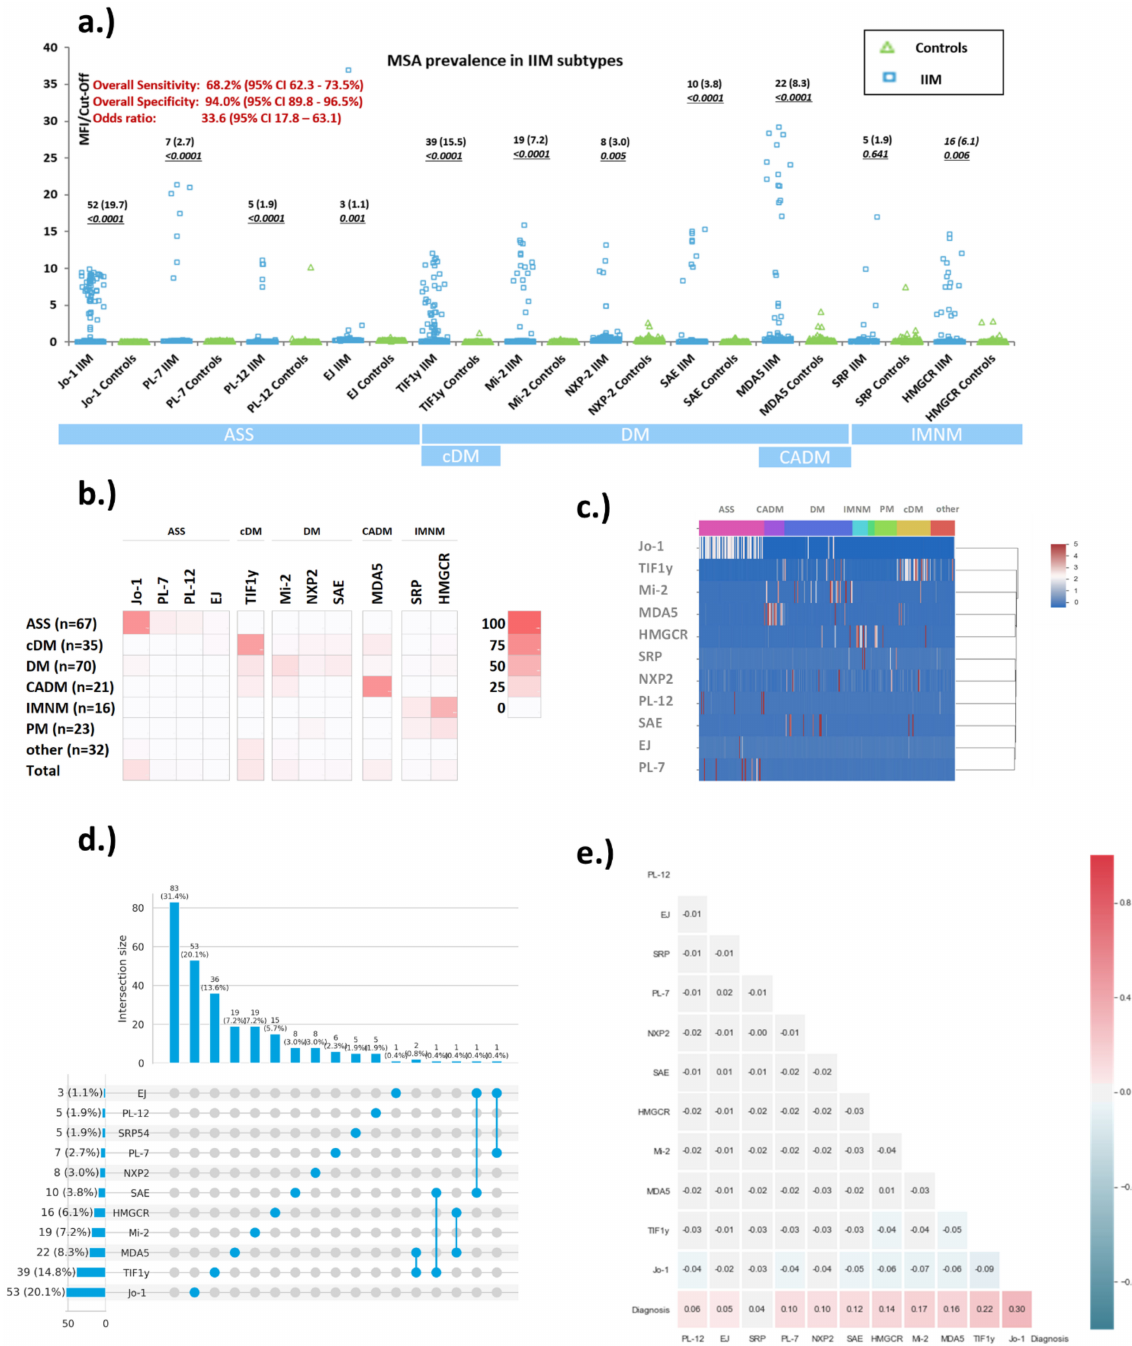
Figure 1. Reactivity of myositis specific antibodies in idiopathic inflammatory myopathy (IIM) patients and controls. ( a ) Scatter plot showing the levels of myositis specific antibodies in different myositis phenotypes as well as in controls. The results derived from particle based multi-analyte technology (PMAT) were normalized by dividing the median fluorescence intensity (MFI) value of the samples by the median fluorescence intensity (MFI) cut-off. ( b ) illustrates the prevalence (%) of the individual MSA in IIM subtypes. ( c ) shows a cluster diagram of MSA. ( d ) Co-existence and correlation of myositis specific antibodies (MSA) for idiopathic inflammatory myopathies (IIM) is depicted using ‘UpSet plot’. As reported in the literature, the majority of MSA are mutually exclusive. ( e ) The correlation diagram shows the relationship between the different markers and the diagnosis. Abbreviations: SRP = signal recognition particle; TIF γ = transcriptional intermediary factor 1 gamma; MDA5 = Melanoma differentiation-associated protein 5; NXP2 = nuclear matrix protein 2; SAE = small ubiquitin-like modifier activating